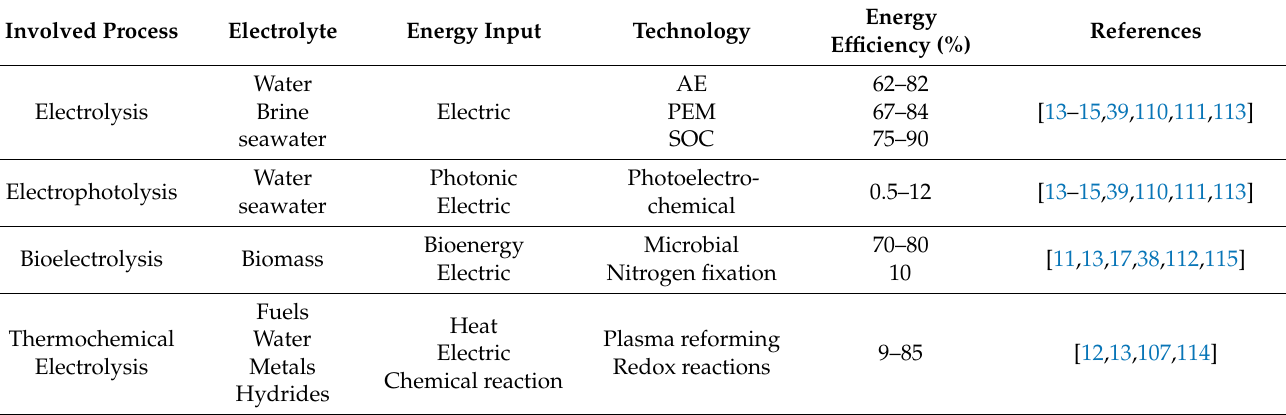
Table 6. Electrochemical based technologies for hydrogen